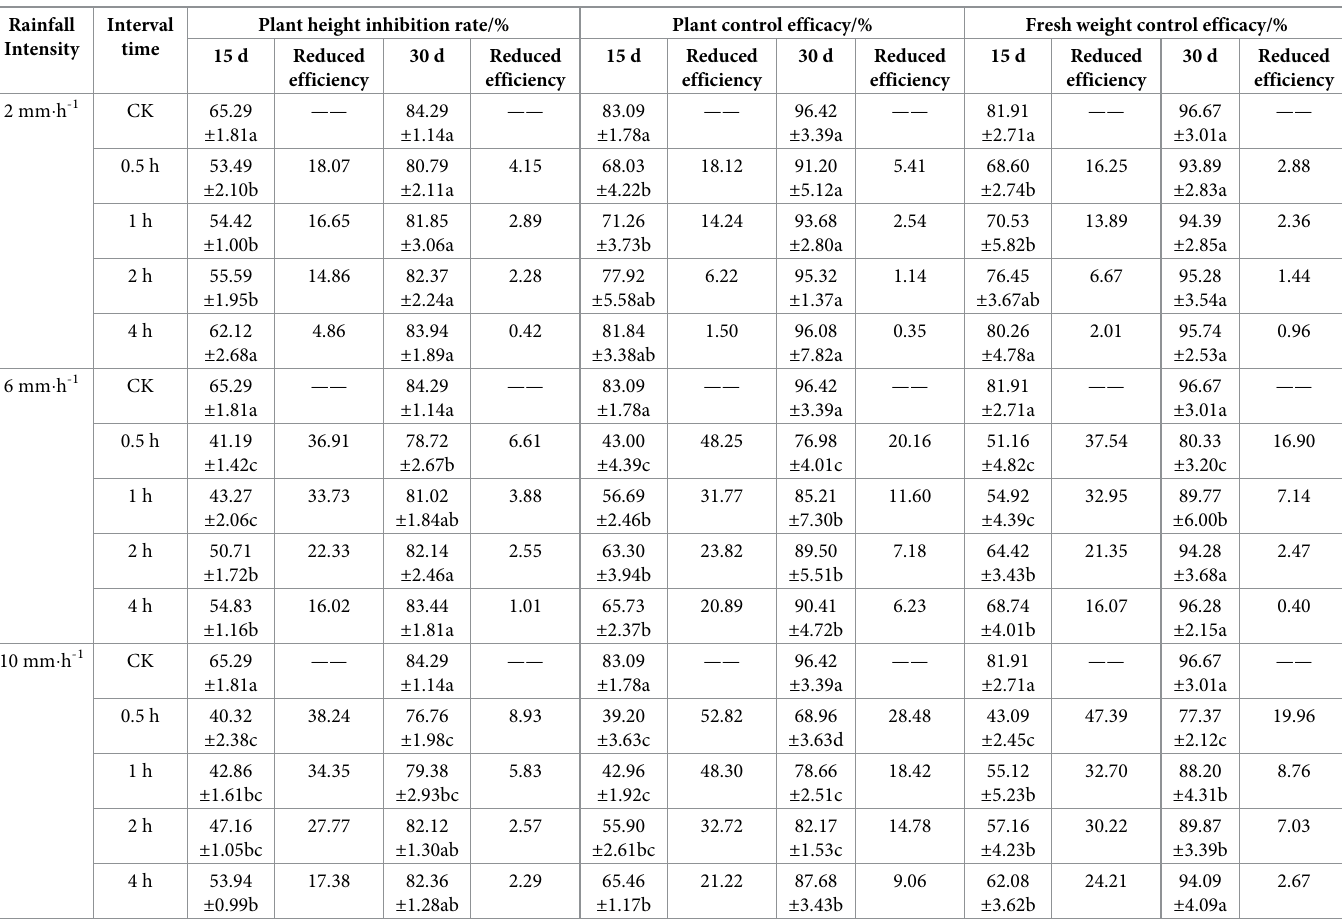
Table 4. Effect of simulated rainfall on the weed control of mesotrione. Rainfall Interval Intensity